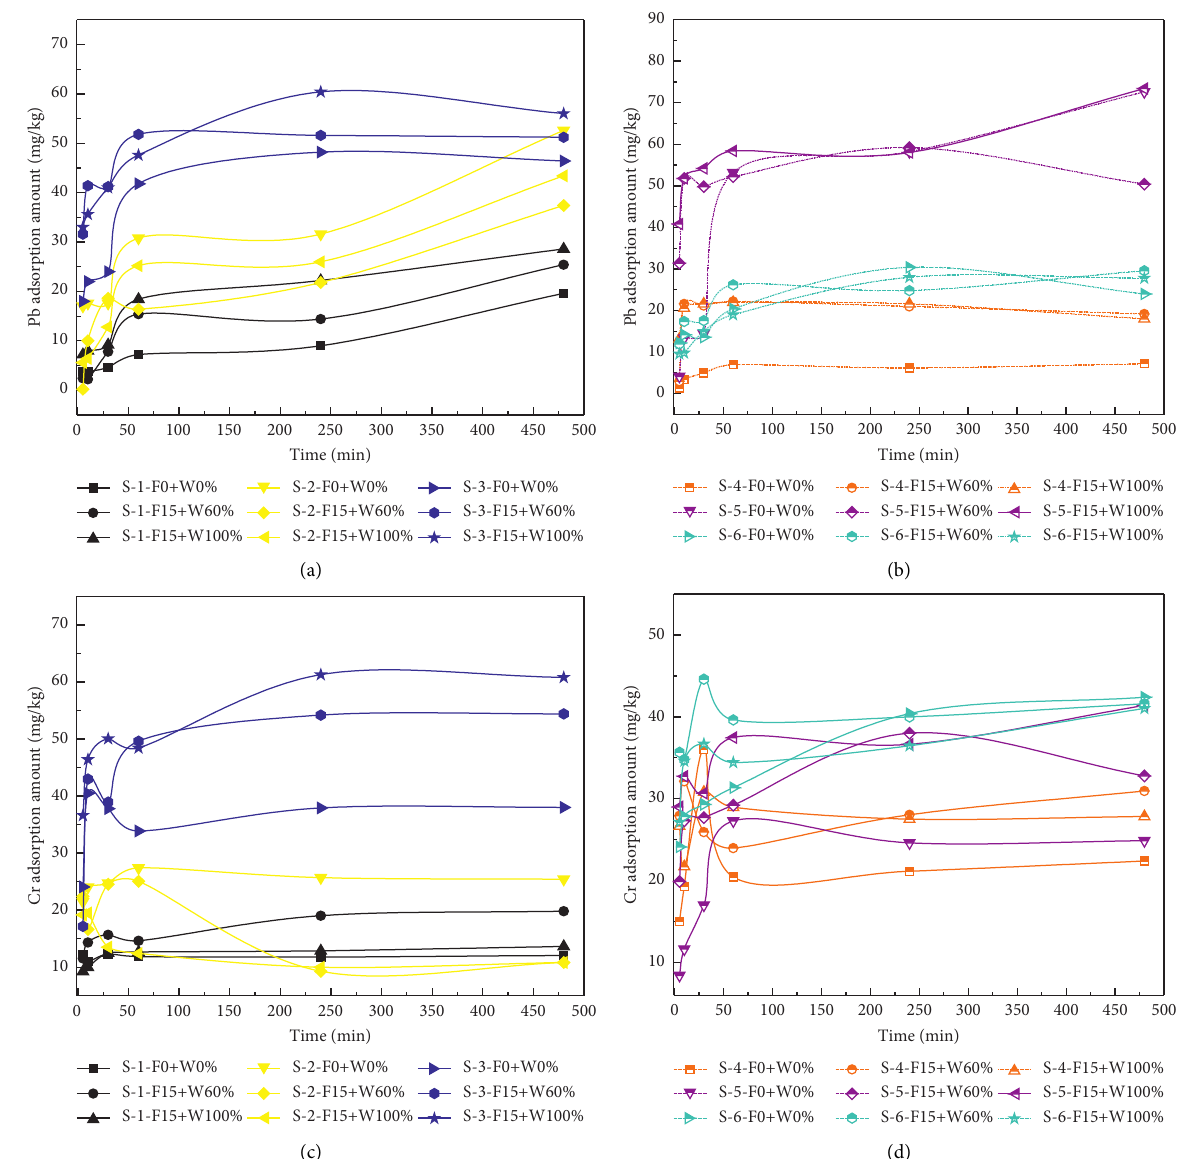
Figure 3: Adsorption amount of the Pb and Cr as a function of stirring time. F0 and F15 refer to the number of freeze-thaw cycles (0 and 15 cycles), and W0%, W60%, and W100% refer to water ratio of field capacity (0%, 60%, and 100% water